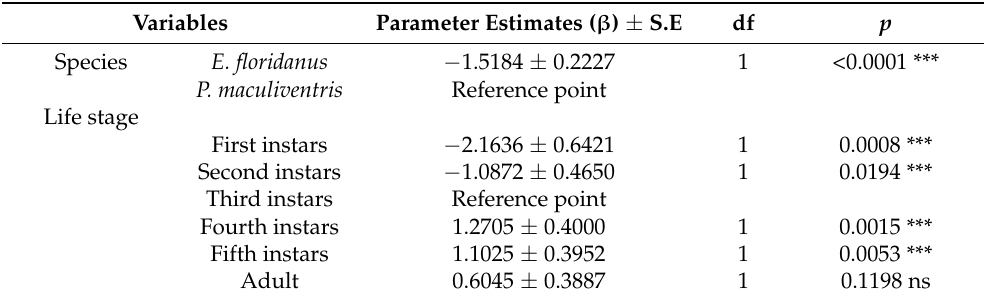
Table 2. Maximum likelihood estimates for all stages of one species being preyed on by adults of the other species.